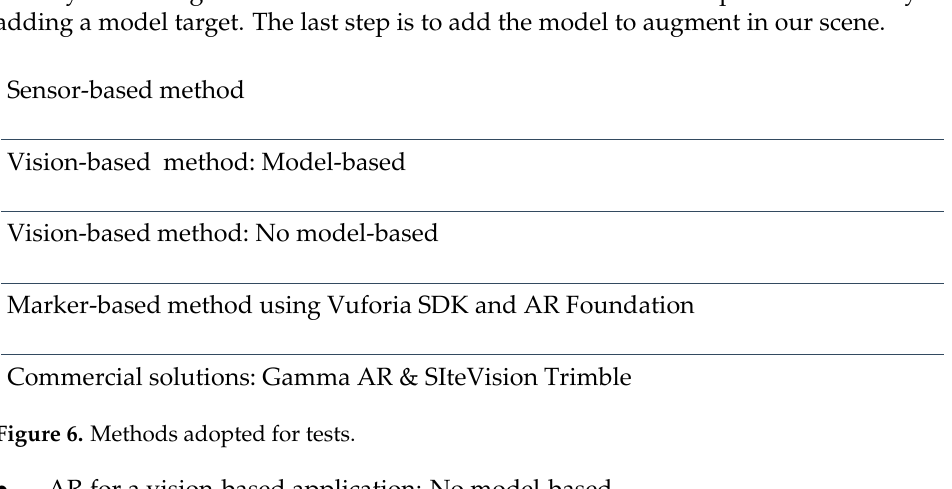
Figure 6. Methods adopted for tests.